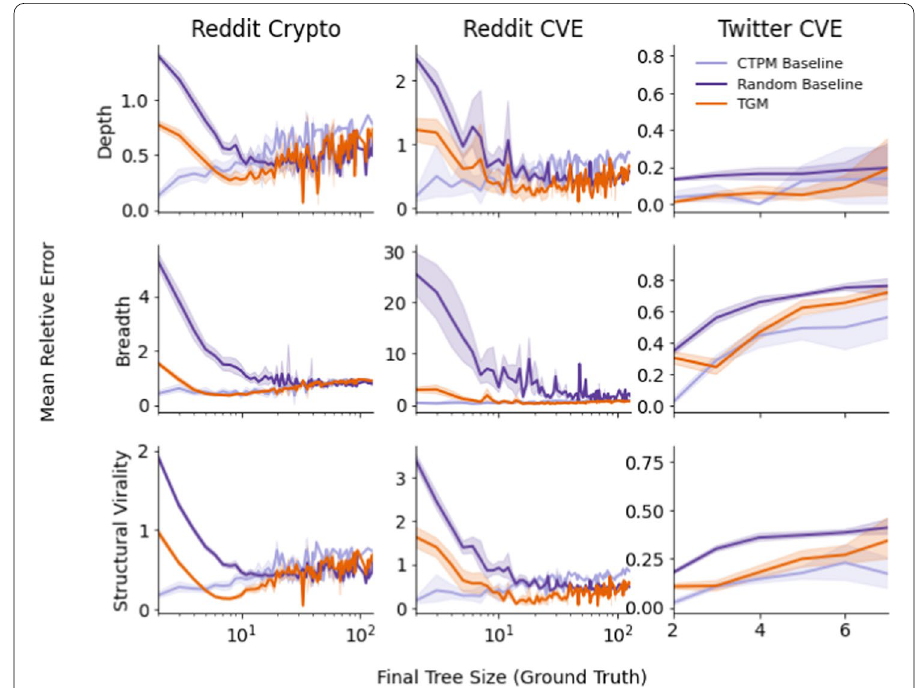
Fig. 9 Mean Relative Error of whole‑tree metrics (depth, breath, and structural virality) versus final tree size of ground truth